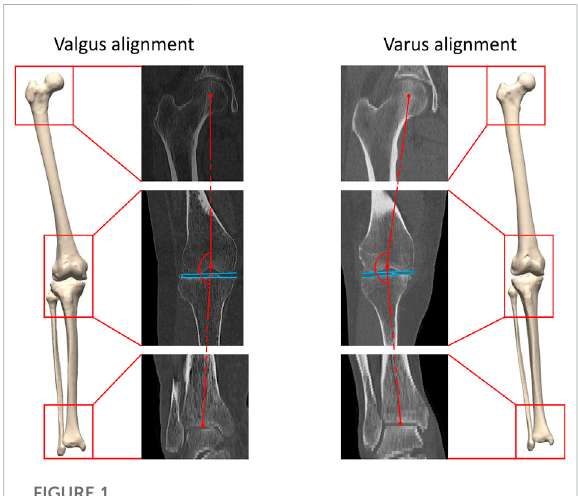
FIGURE 1 A three-dimensional lower limb model is developed starting from the available CT data. Both valgus alignment (left) and varus alignment (right) are visualized. Typically, valgus alignment (left) is de fi ned as a hip-knee-ankle (HKA) angle smaller than or equaling 177 ° whereas varus alignment (right) involves a HKA angle equaling or exceeding 183 ° (Hirschmann et al., 2019). The HKA angle is formed interconnecting the center of the hip, of the knee andoftheankleinthecoronalplane,visualizedinred.Thetangent to the distal femoral bone and to the proximal tibia plateau are visualized in